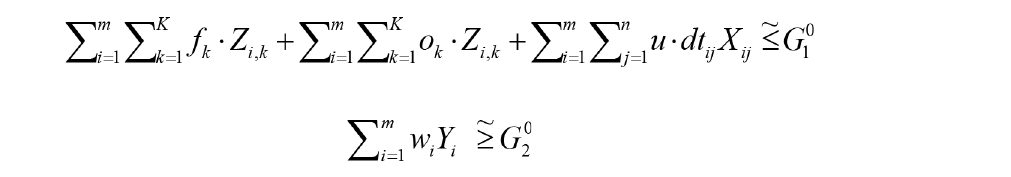
Figure 2. Objective function as fuzzy numbers of min G